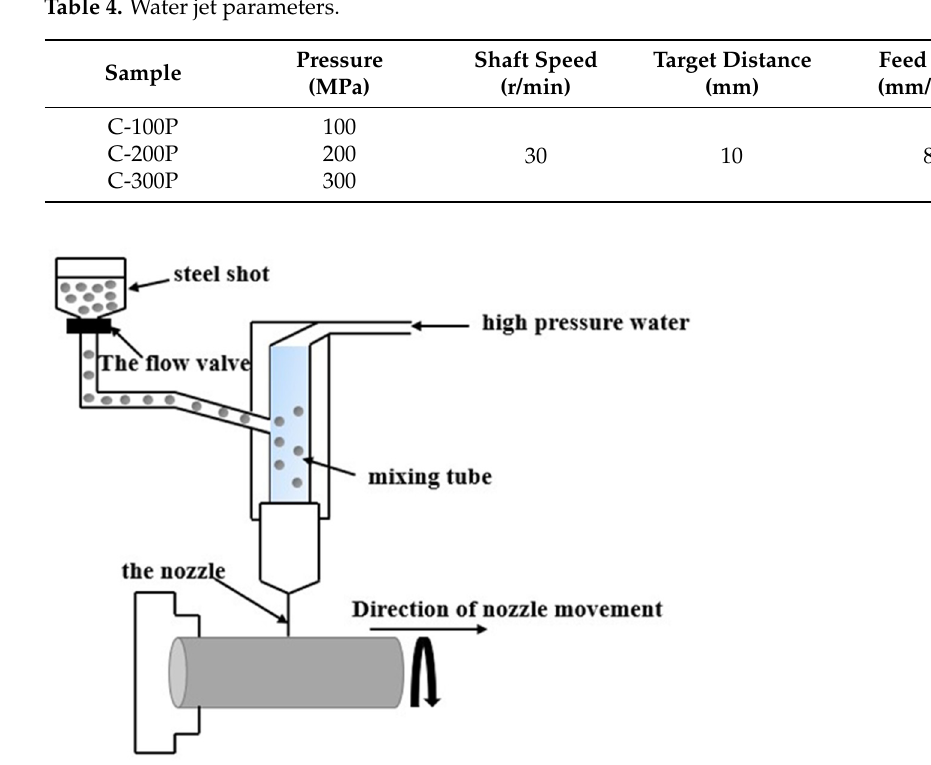
Table 3. Nitrided treatments of the C and the original specimens.